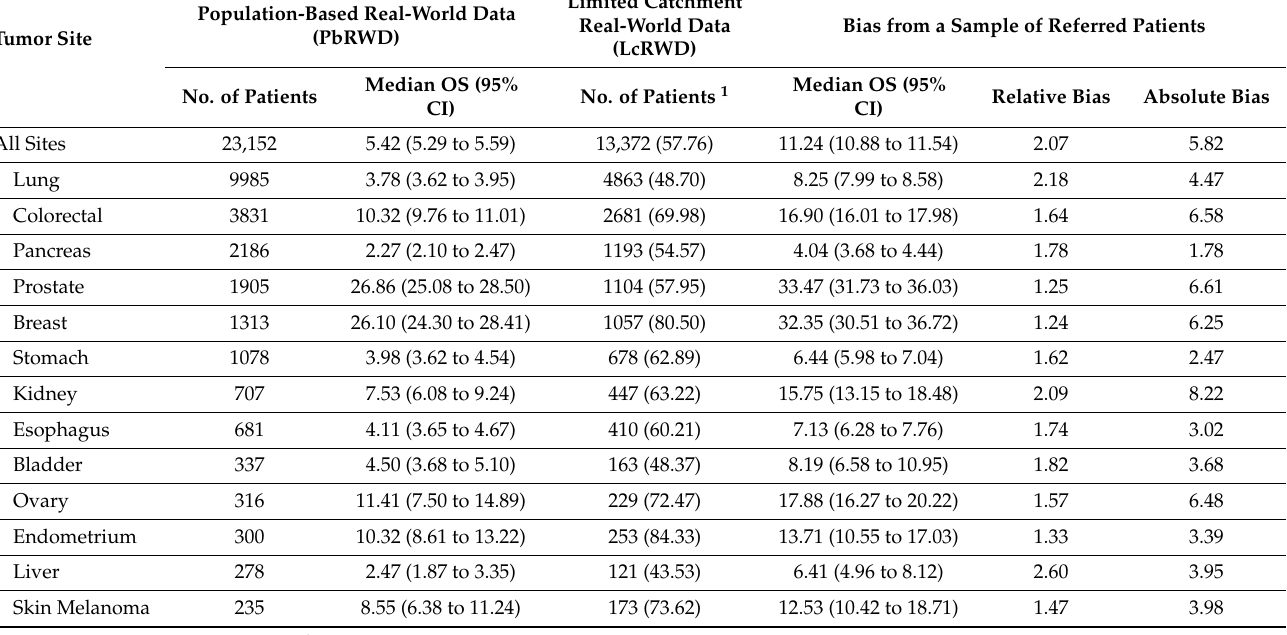
Table 2. Difference in the median overall survival from diagnosis of newly metastatic-diagnosed cancer patients in Alberta treated (2010–2019) at the population-level versus among individuals referred to medical